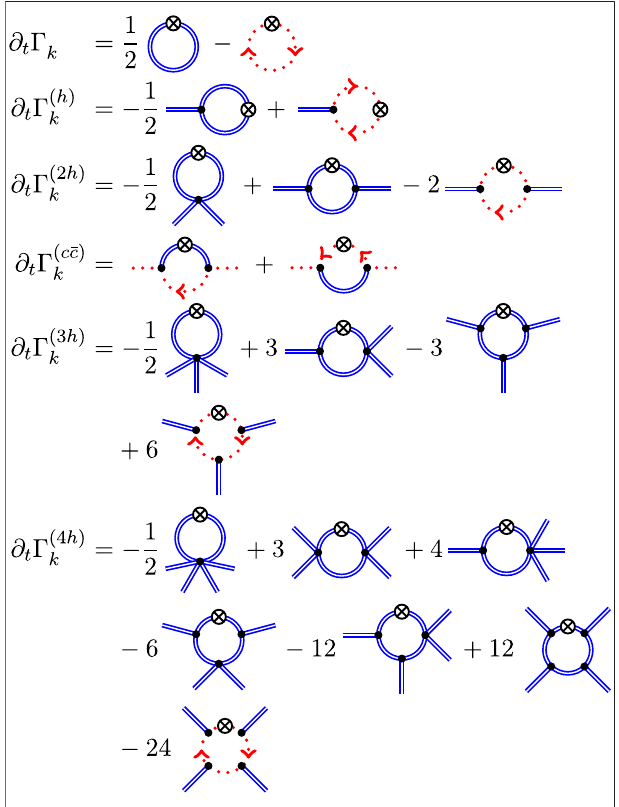
FIGURE 4 | Diagrammatic representation of the fl ow equations of the fl uctuation n -point functions up to n (cid:2) 4. Graviton propagators are depicted with a blue double line and ghosts with a red dotted line. The crossed circle represents a regulator insertion. The fl ows can be augmented straightforwardly with contributions from matter fi elds. The fi gure is taken from